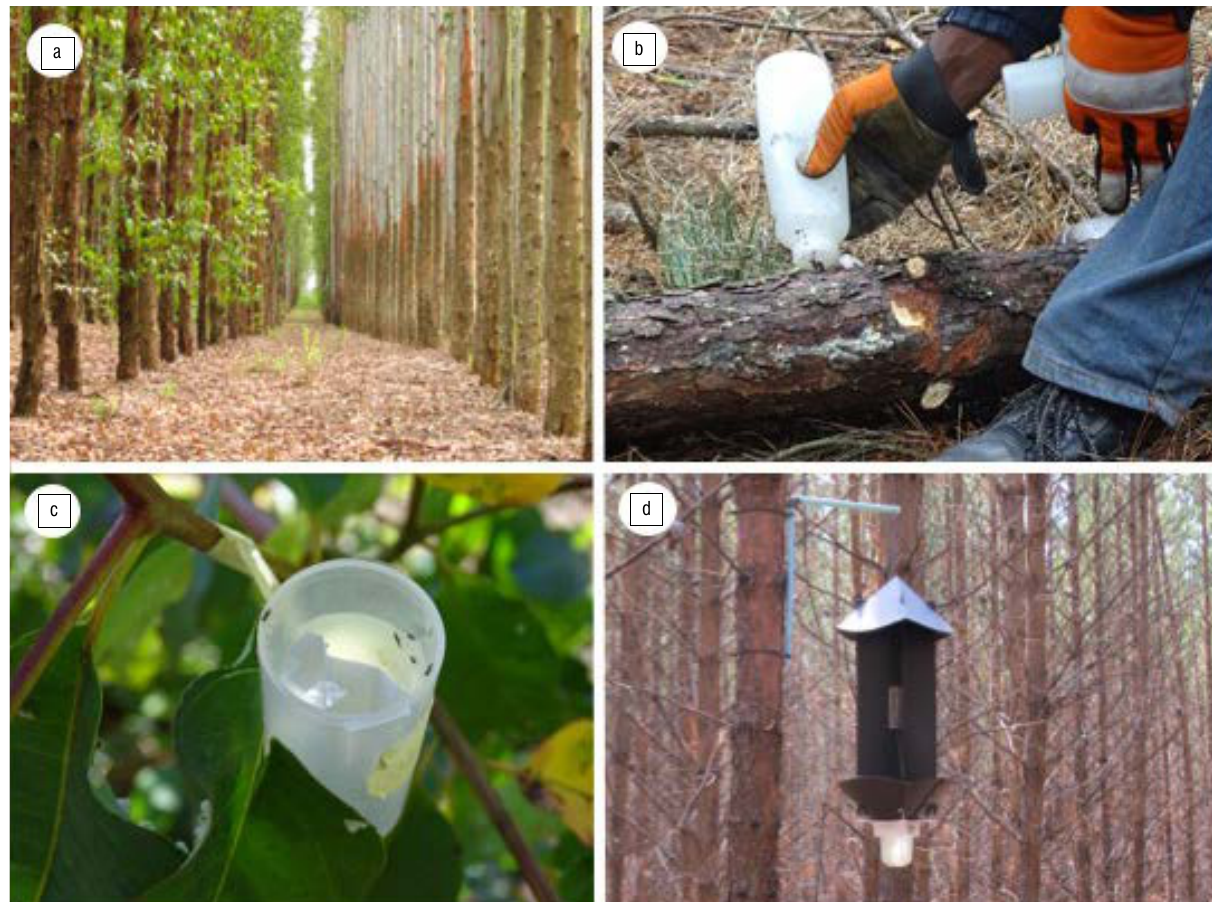
Figure 2: Management strategies for pathogens and insect pests of plantation trees in South Africa: (a) a clone of Eucalyptus grandis seriously damaged by Coniothyrium canker caused by Teratosphaeria zuluensis, alongside a disease tolerant clone, illustrating the potential benefits of breeding for resistance; (b) inoculating the nematode Deladenus siricidicola into a pine tree infested with Sirex noctilio , as part of a successful biological control programme first implemented in South Africa in 1995; (c) releases of the parasitic wasp Psyllaephagus bliteus to control the red gum lerp psyllid, Glycaspis brimblecombei ; (d) a lure-based trap used to monitor populations of S. noctilio and thus inform management